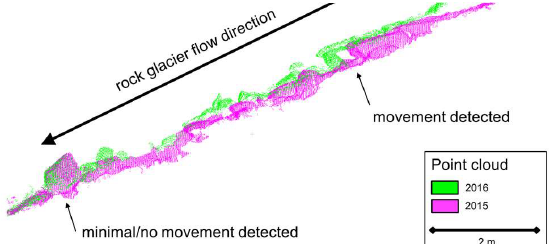
Figure 4. Differences in terrestrial laser scanning point clouds due to rock glacier movement between 2016 and